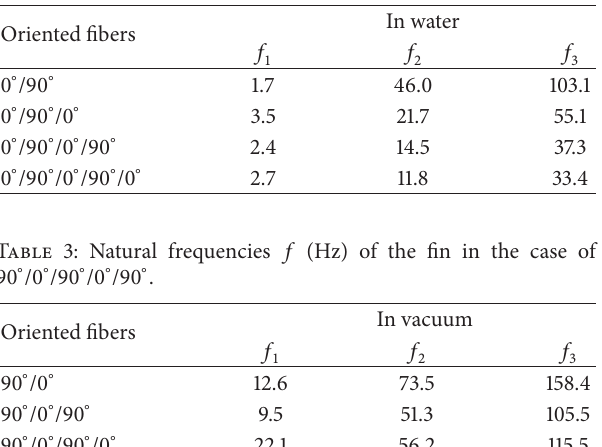
Table 2: Natural frequencies 𝑓 (Hz) of the fin in the case of 0 ∘ /90 ∘ /0 ∘ /90 ∘ /0 ∘ .